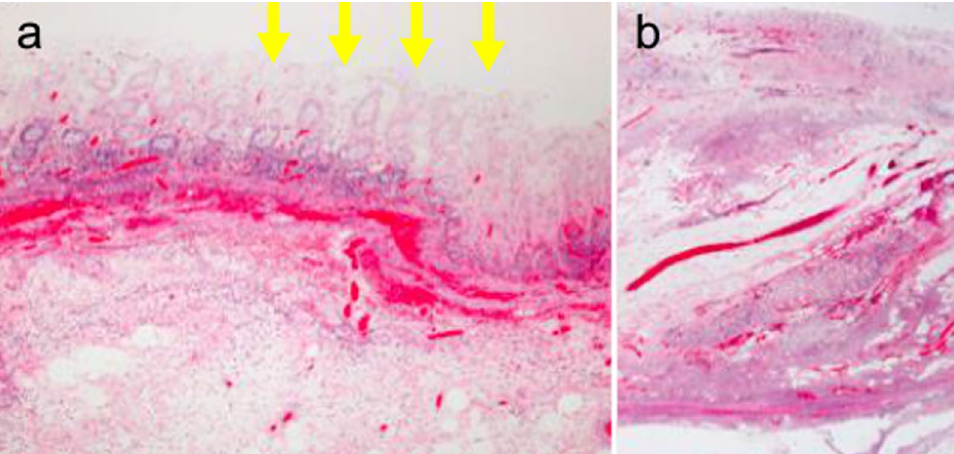
Fig. 4 Histopathological examination. a A withering necrotic gland duct characteristic of ischemic enteritis is observed (arrow). b In the inflamed areas, inflammatory cell infiltration with neutrophils is observed. There is no stenosis of blood vessels or thrombus that could cause intestinal